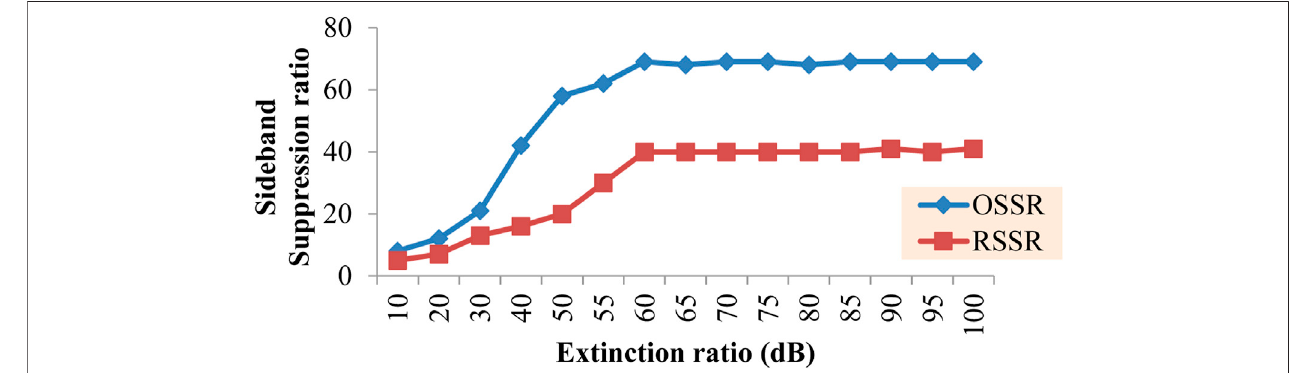
FIGURE 7 | Impact of the MZM extinction ratio on the sideband suppression ratio.